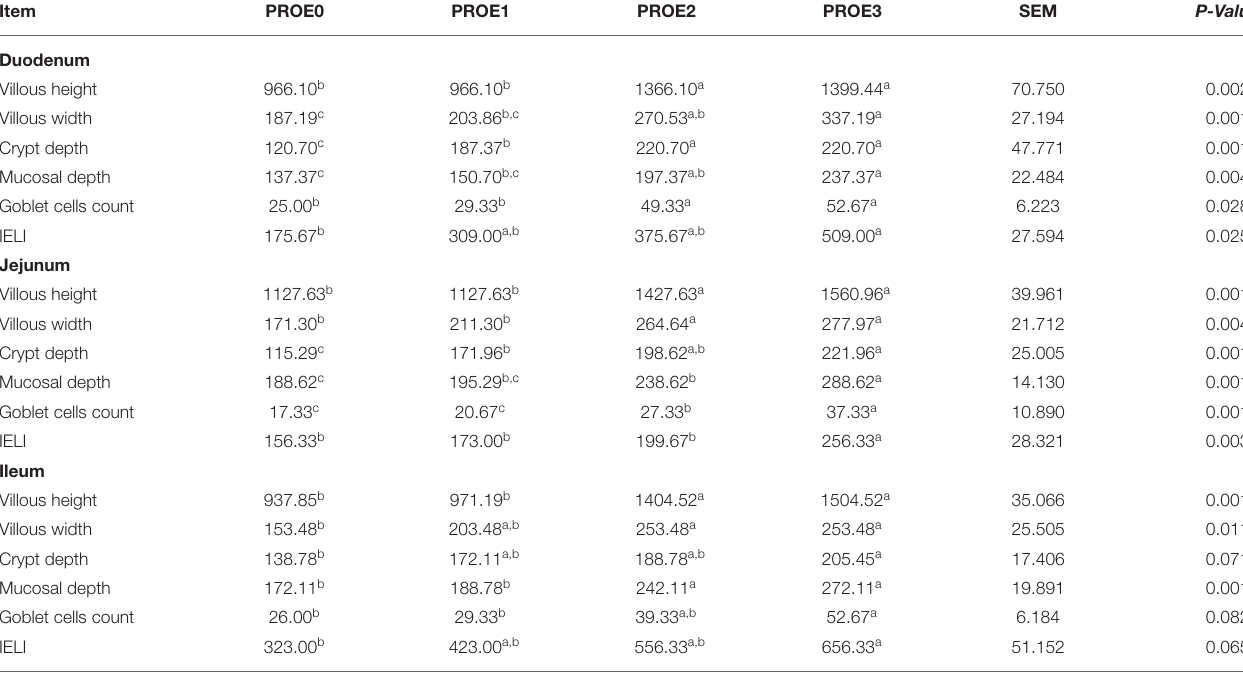
TABLE 7 | The effect of PROE supplementation on the morphometric measures of the small intestine of broiler chickens. Item